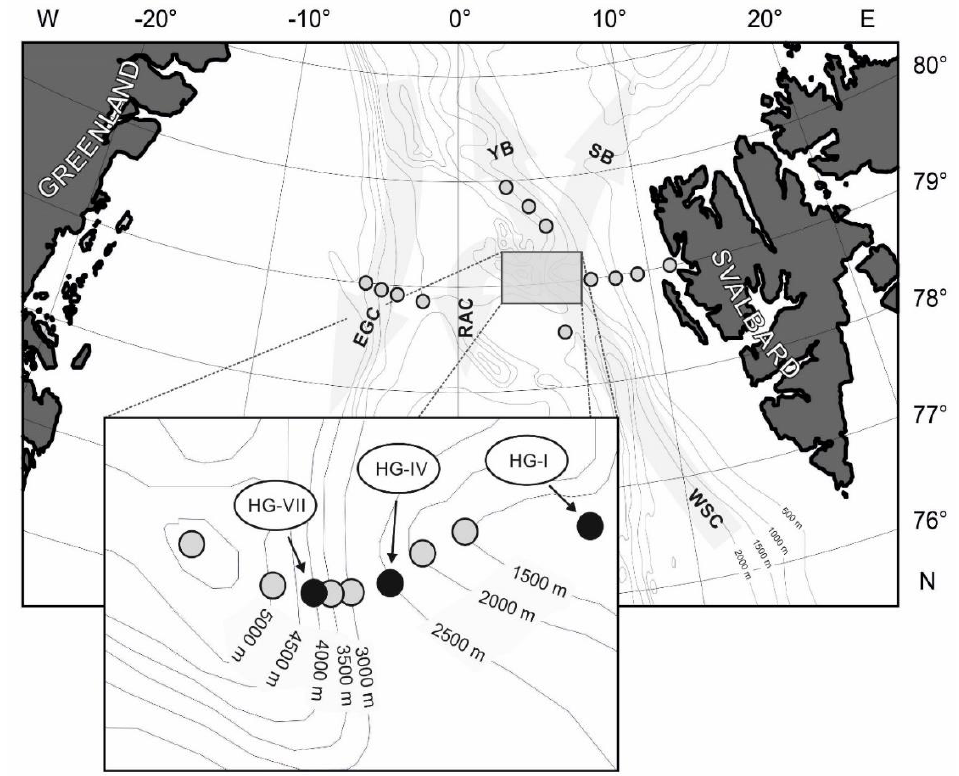
Figure 1. Network of permanent sampling sites at the LTER (Long-Term Ecological Research) observatory HAUSGARTEN in Fram Strait (grey circles) and selected sites for meiofauna long-term studies (black circles). Major currents in the strait: WSC—West Spitsbergen Current, EGC—Eastern Greenland Current, RAC—Return Atlantic Current, YB—Yermak Branch, and SB - Svalbard Branch of the WSC.